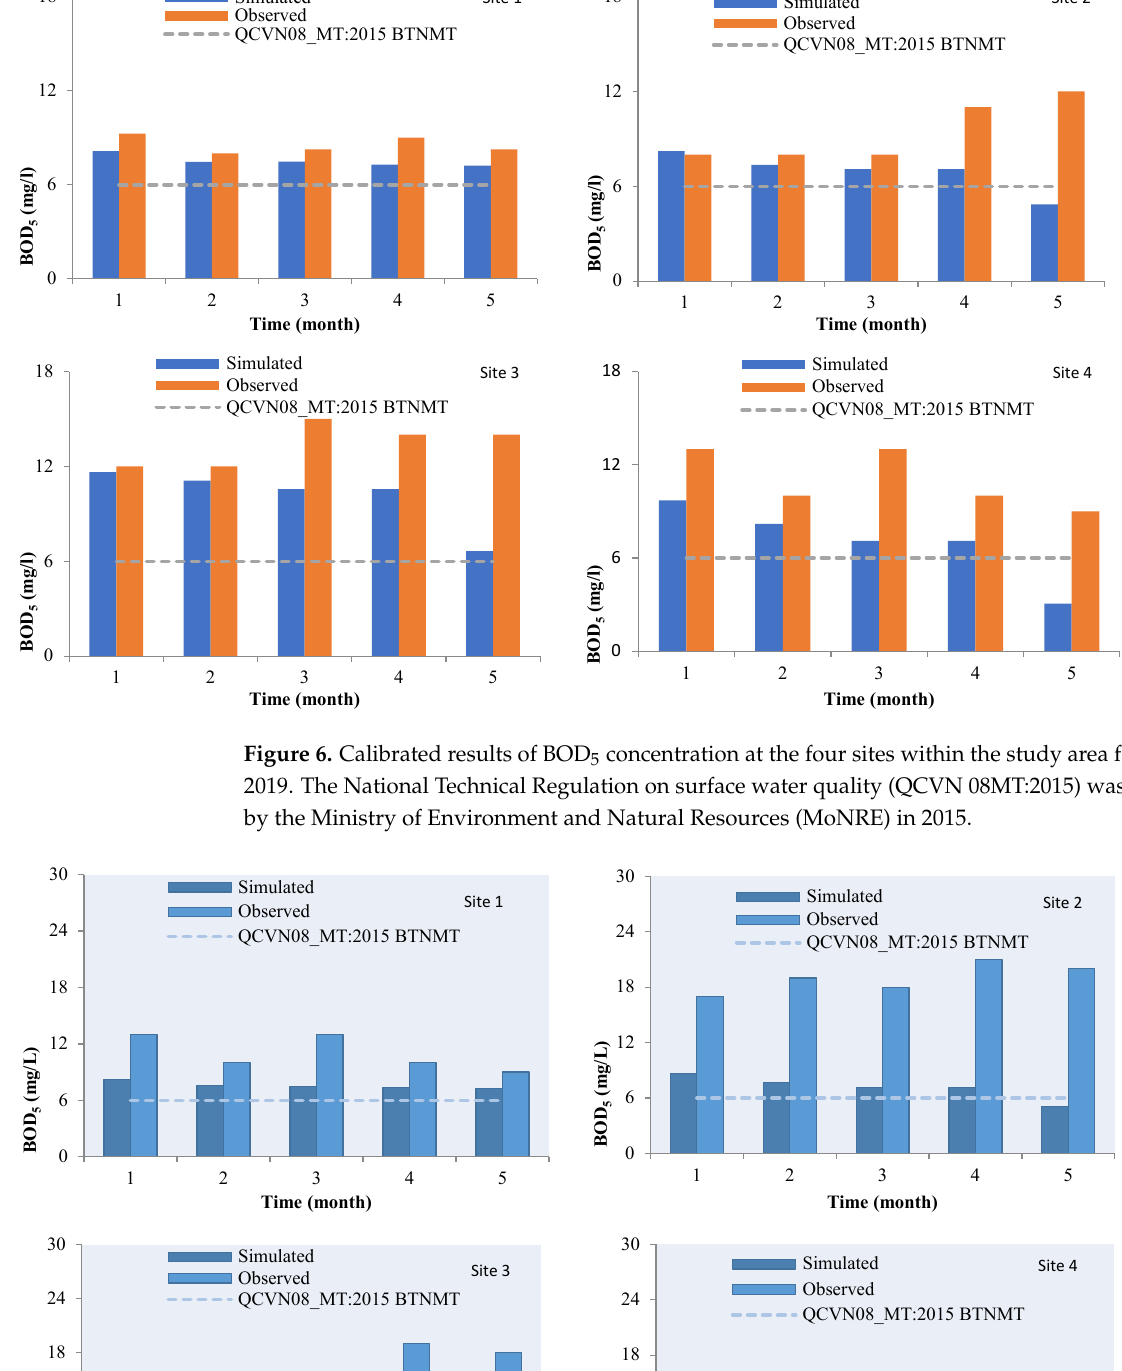
Figure 7. Validated results of BOD 5 concentration at the four locations within the study area for the year 2020.